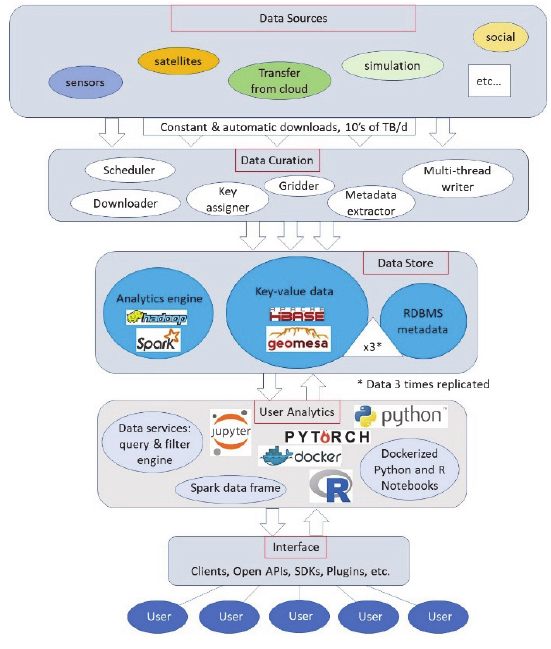
Figure 1: PAIRS Geoscope Architecture